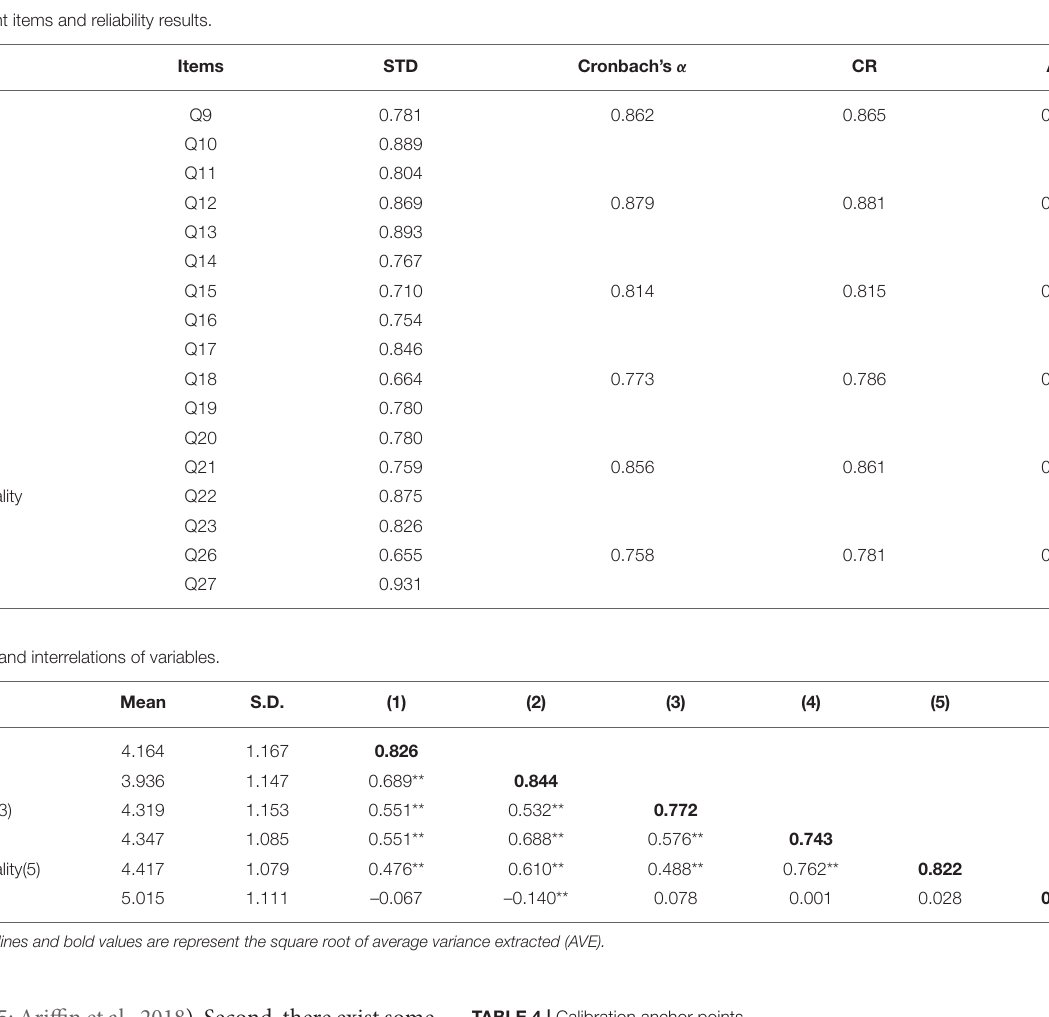
TABLE 4 | Calibration anchor points.